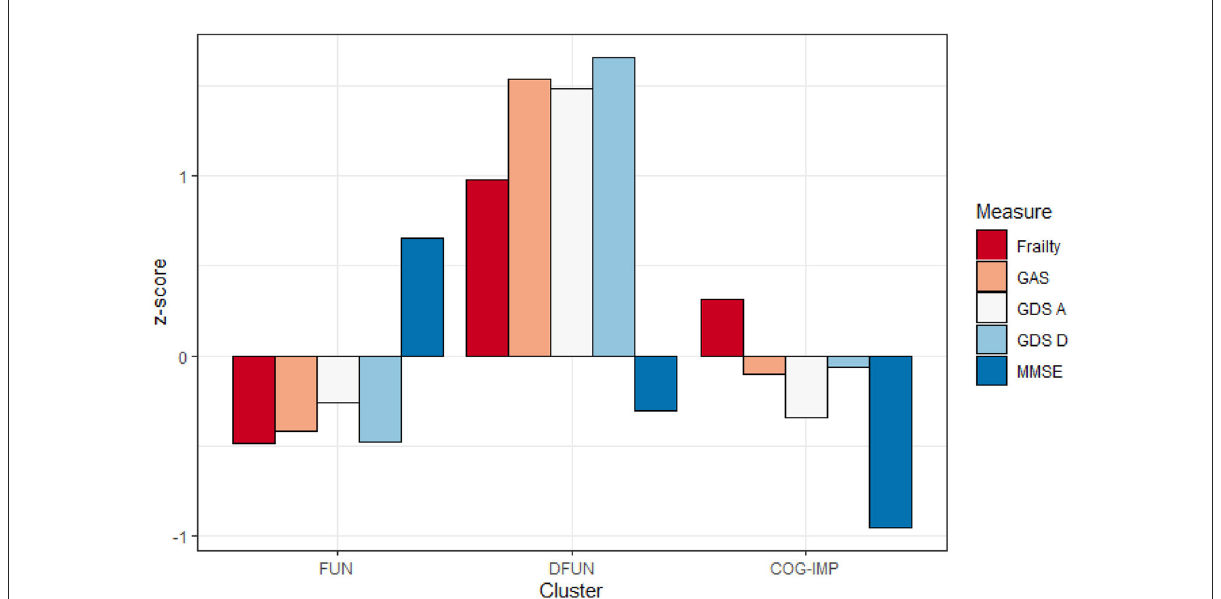
FIGURE2 Average values of frailty score, Geriatric Anxiety Scale (GAS), Geriatric Depression Scale—lack of positive affect (GDS A), Geriatric Depression Scale—dysphoria (GDS D), and Mini-Mental State Examination (MMSE), expressed as z -scores in three identified clusters: Functional (FUN), Dysfunctional (DFUN), and Cognitive impaired (COG-IMP).